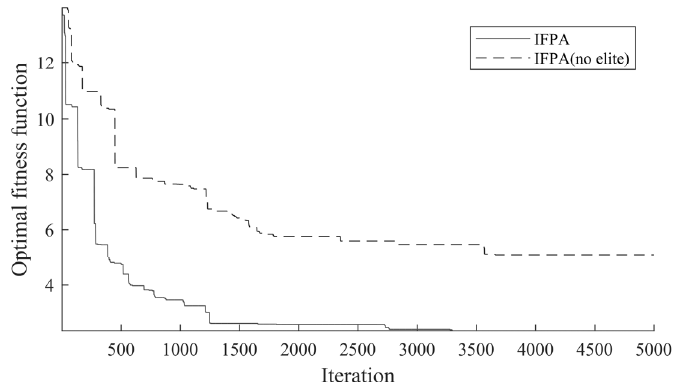
Figure 3. Fitness function curves before and after adding tournament selection mechanism.